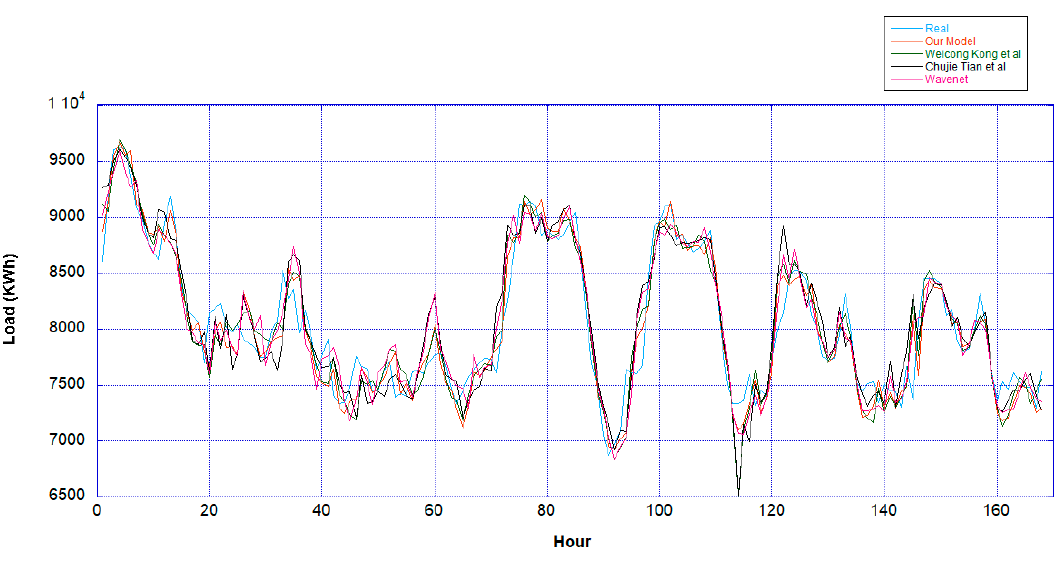
Figure 9. Forecasting result using ENTSO-E dataset 1.